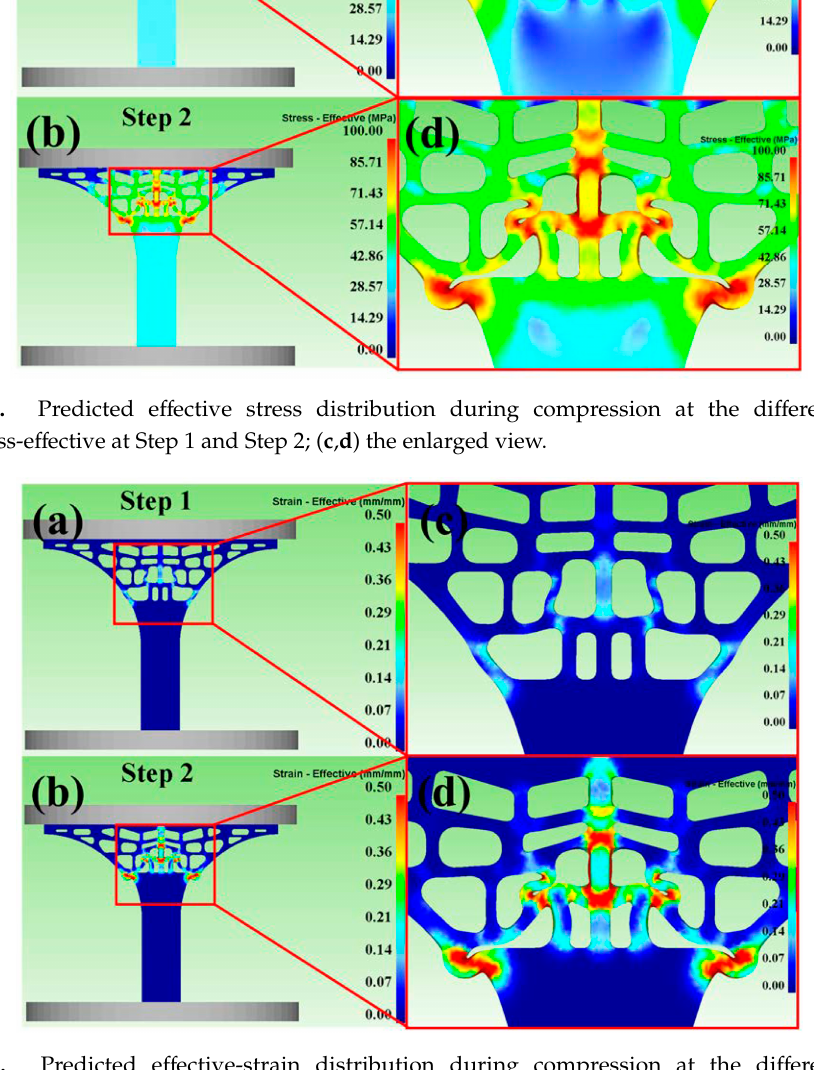
Figure 6. Predicted effective-strain distribution during compression at the different steps ( a , b ) Strain-Effective at Step 1 and Step 2; ( c , d ) the magnified view. Table 2. The ultimate compressive strength ( σ ) and strain-to-failure ( ε ) of the tree column structures-type AlSi10Mg alloy branches and a full (non-porous) structure samples with identical